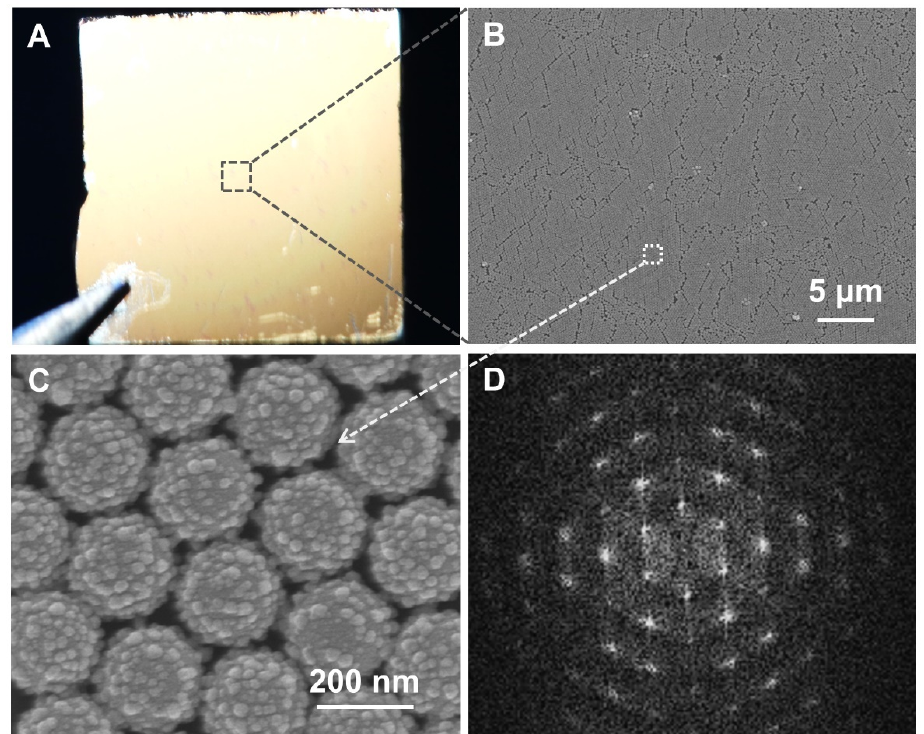
Figure 3. ( A ) Photograph, ( B , C ) SEM images, and ( D ) FFT pattern of a SiO 2